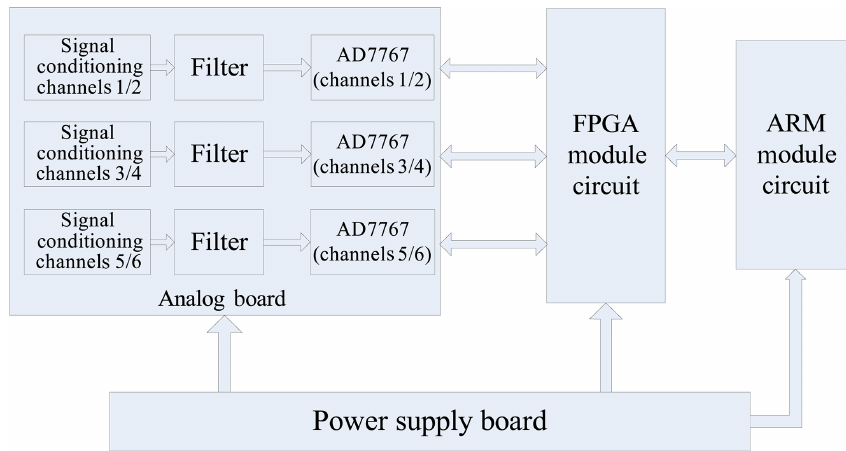
Figure 1. System block diagram of hardware.